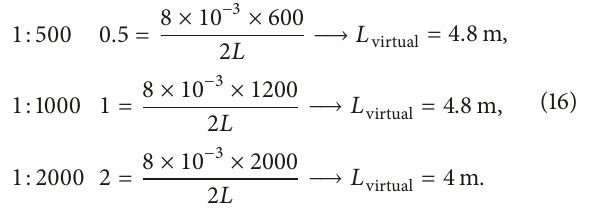
Table 2: Parameters of common aerial photogrammetric aircraft.